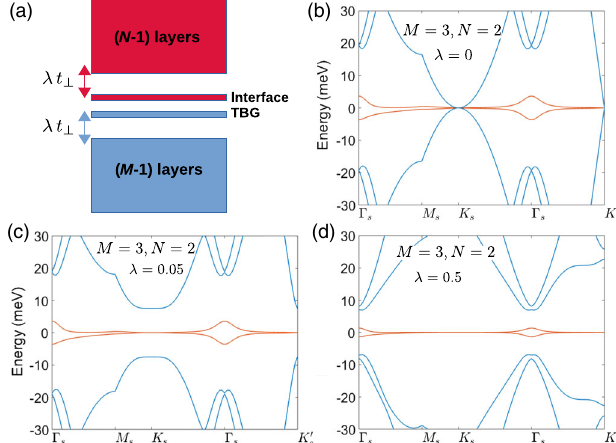
FIG. 5. (a) A schematic illustration of the TMG system. (b) – (d) The band structures of ( 2 þ 3 )-layer TMG at θ ¼ 1 . 05 °. The coupling parameter between the interface and the top (bottom) multilayers has been rescaled by λ : (b) λ ¼ 0 , (c) λ ¼ 0 . 05 , and (d) λ ¼ 0 . 5